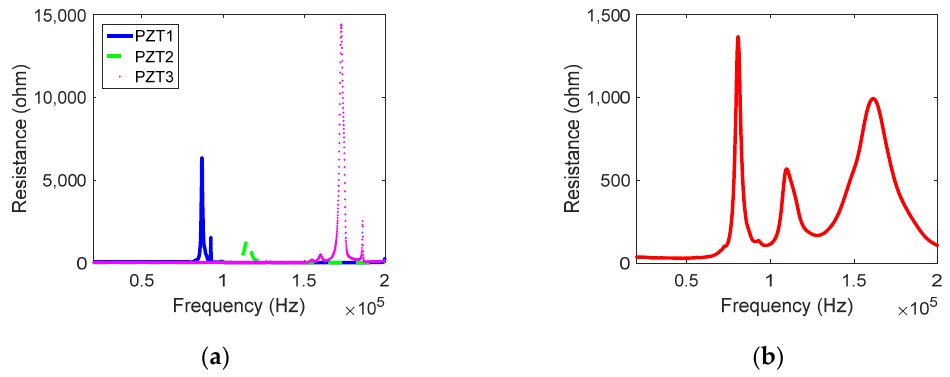
Figure 7. The measured impedance signature of PZTs for unloaded conditions and loaded conditions: ( a ) unloaded condition; ( b ) loaded conditions.